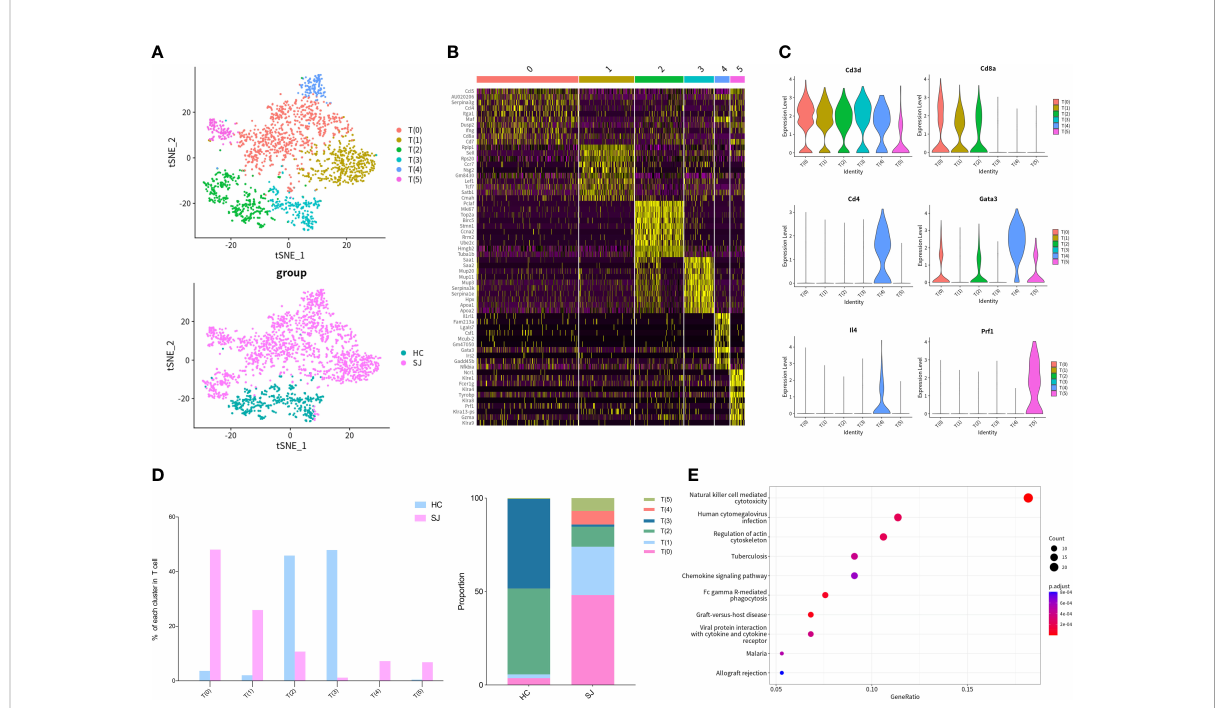
FIGURE 2 Th2 cells and NKT cells in fi brotic liver of schistosomiasis japonica. (A) tSNE plots of the 2,045 T cells for six clusters and two groups. (B) Heatmap of T cells for the top 10 DEGs of each cluster. (C) Violin plots of genes in each T cell cluster. (D) The percentage change tendency and contribution of each T cell cluster in two groups. (E) Bubble plots of KEGG pathway enrichment DEGs between T(5) and other T